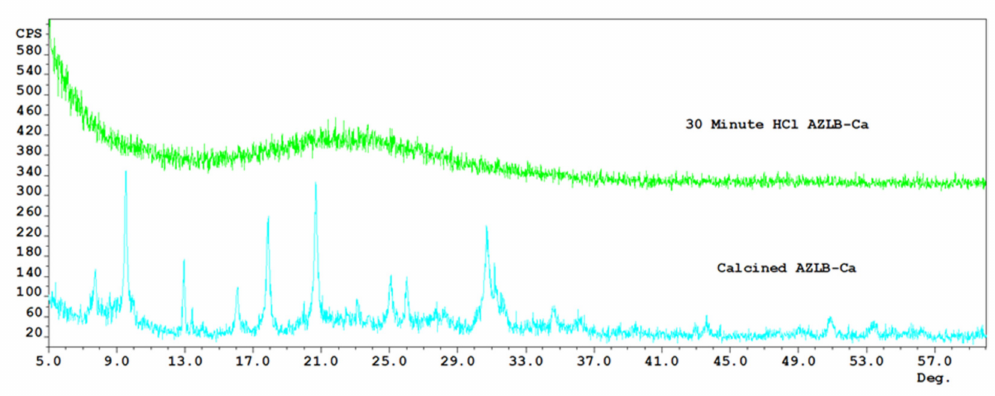
Figure 5. The XRD patterns of calcined AZLB-Ca and 30 min HCl AZLB-Ca.